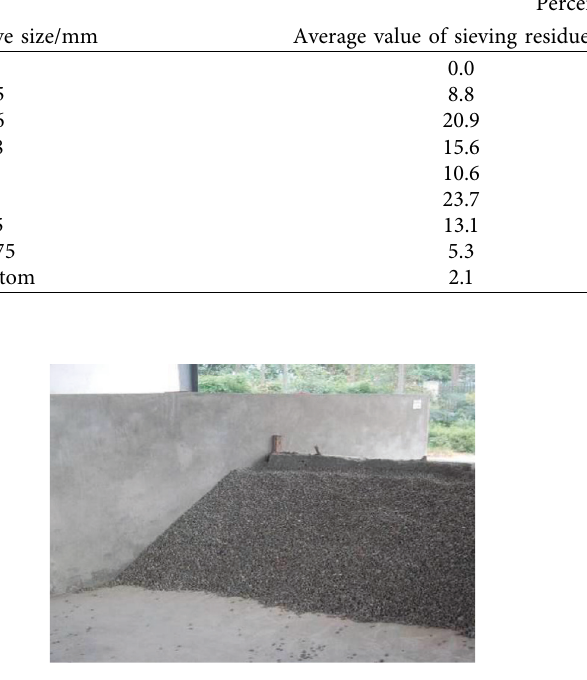
Figure 1: Coarse aggregate.